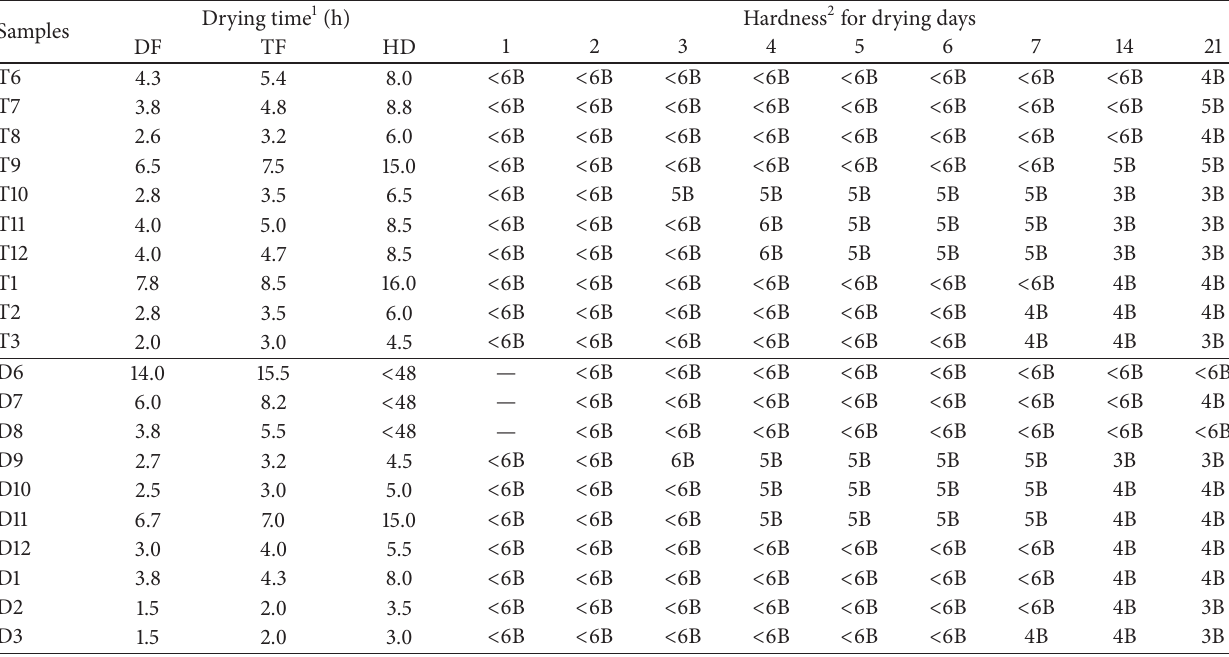
Table 2: Compositions of season Vietnamese lacquer.